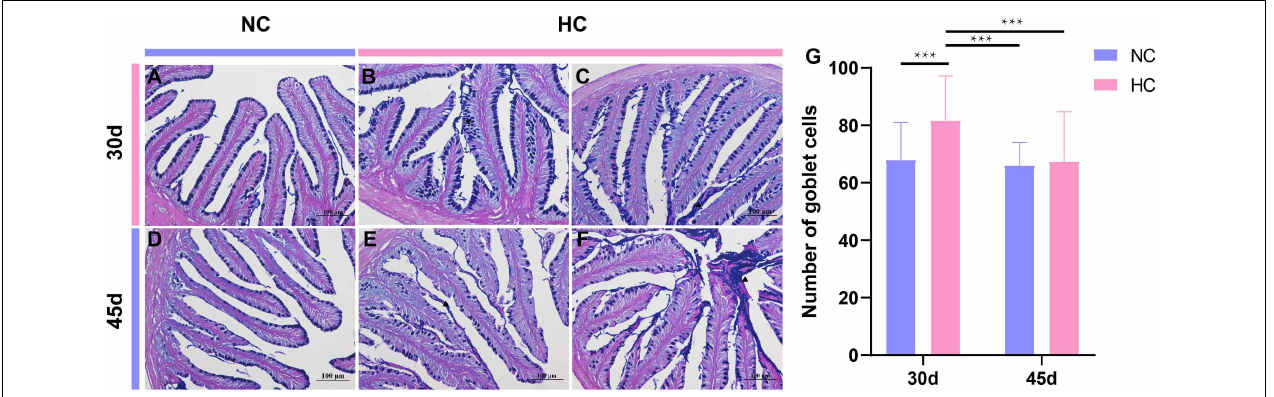
FIGURE 5 | Intestinal goblet cells observations of the largemouth bass intestine (AB-PAS staining) (A) The number and distribution of intestinal goblet cells in fish fed the NC diet for 30 days; (B,C) proliferation of goblet cells (pentagram), increased mucus secretion (triangles) of fish fed the HC diet for 30 days; (D) number and distribution of intestinal goblet cells in NC-fed fish after 45 days; (E,F) , the number of goblet cells decreased in HC-fed fish at 45 days, and a large amount of mucus was secreted into the intestinal lumen (triangle); (G) number of intestinal goblet cells in largemouth bass fed the NC and HC diets for 30 and 45 days (*** P < 0.001. NC: 0% α -starch diet, FC: 22% α -starch